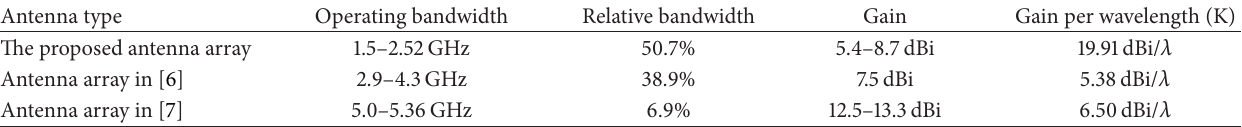
Figure 9: Simulated and measured radiation patterns: (a) 2.0 GHz, E-plane, (b) 2.4 GHz, E-plane, (c) 2.0 GHz, H-plane, and (d) 2.4 GHz, H-plane. Table 2: Antenna performance comparison between the antennas proposed in this paper and other